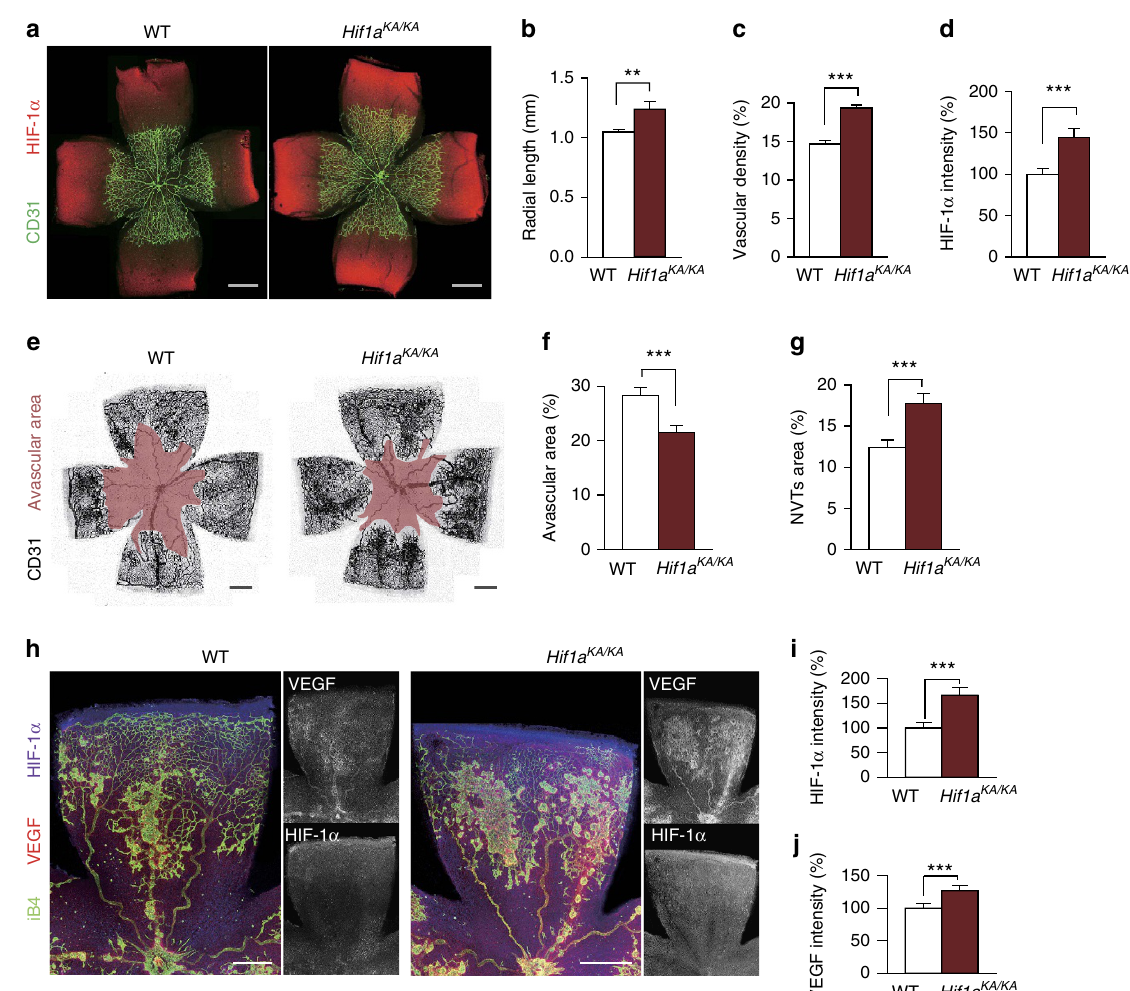
Figure 5 | Enhanced retinal angiogenesis in Hif1a KA/KA knock-in mice. ( a – d ) Physiological retinal angiogenesis at postnatal day 5 (P5) in WT and Hif1a KA/KA mice. ( a ) P5 retina whole mount-stained with anti-CD31 and anti-HIF-1 a antibodies. Scale bars, 500 m m. ( b – d ) Comparisons of blood vessel radial length, vascular density and signal intensity of HIF-1 a . Values are mean ± s.d. ( n ¼ 4 for each group, t -test, ** P o 0.01, *** P o 0.001). ( e – j ) Pathologic retinal angiogenesis in an OIR model of WT and Hif1a KA/KA mice. ( e ) P17 OIR retina whole mount stained with anti-CD31 antibody. Avascular areas are highlighted in pink. Scale bars, 500 m m. ( f , g ) Comparisons of avascular and neovascular tuft (NVT) areas. Values are mean ± s.d. ( n ¼ 4 for WT, n ¼ 8 for Hif1a KA/KA , t -test, *** P o 0.001). ( h ) P17 OIR retina stained with anti-isolectin B4 (iB4), anti-VEGF and anti-HIF-1 a antibodies. Scale bars, 500 m m. ( i , j ) Comparisons of signal intensities of HIF-1 a and VEGF. Values are mean ± s.d. ( n ¼ 4 for each group, t -test, *** P o